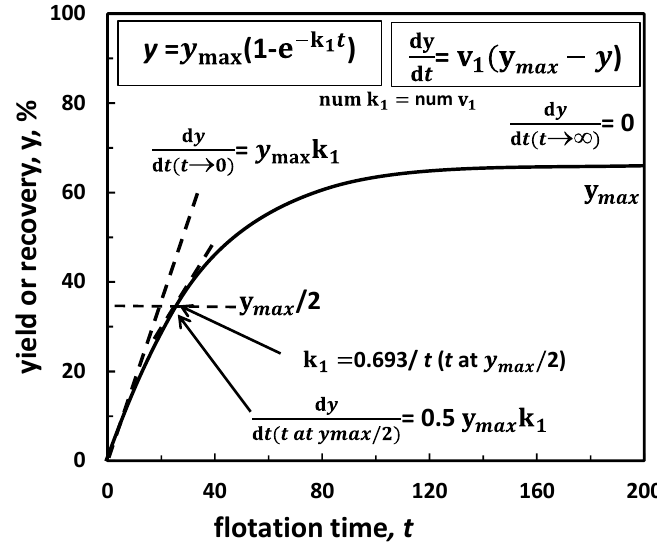
Figure 10. Yield (or recovery) of flotation as a function of time at a given frother concentration provides various data including yield (or recovery) trend, maximum flotation yield (or recovery) ( y max ), flotation kinetics ( v , k ), which can be used for frothers classification in the water/gas/solid system. The case of first order process rate.